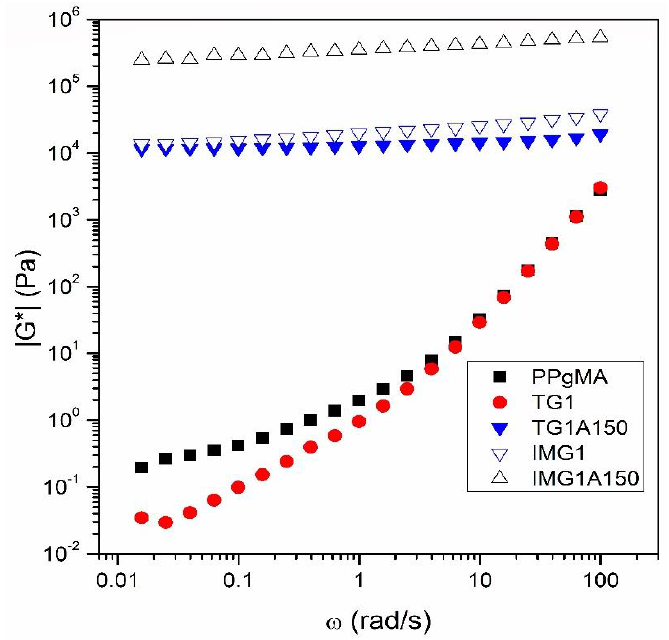
Figure 10. The change in complex modulus (|G*|) of the cross-linked products at various angular frequency (ω, rad/s) and measured at temperature of 160 °C.